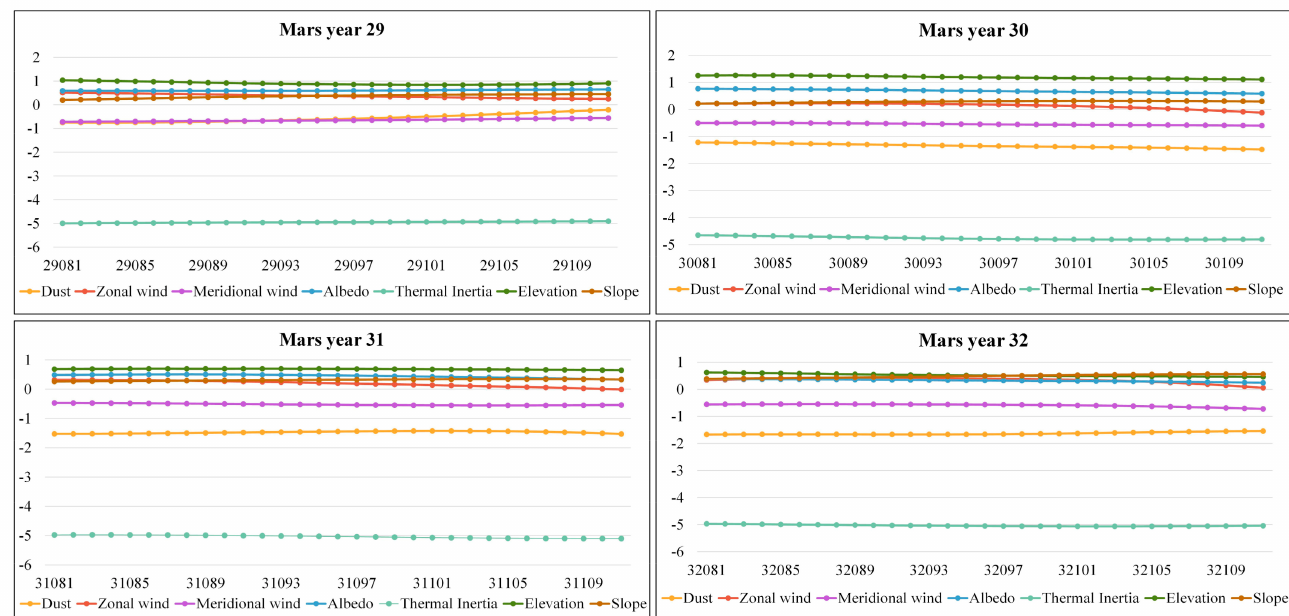
Figure 10. The temporal trend in the coefficient of independent variables for STR based on the GTWR model during 81–111 sol from Martian years 29 to